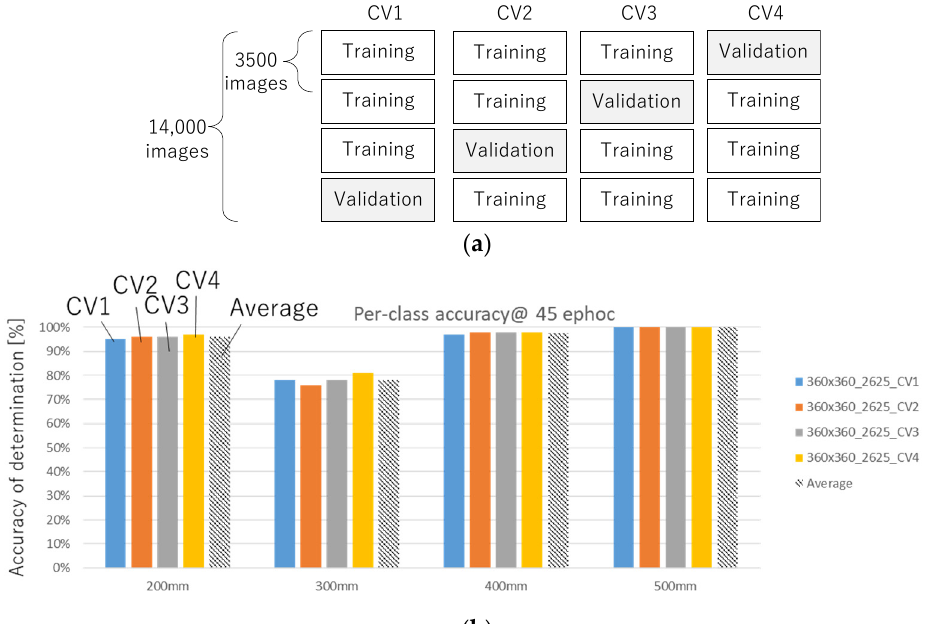
Figure A7. K-fold cross validation: ( a ) schematic; ( b ) result.